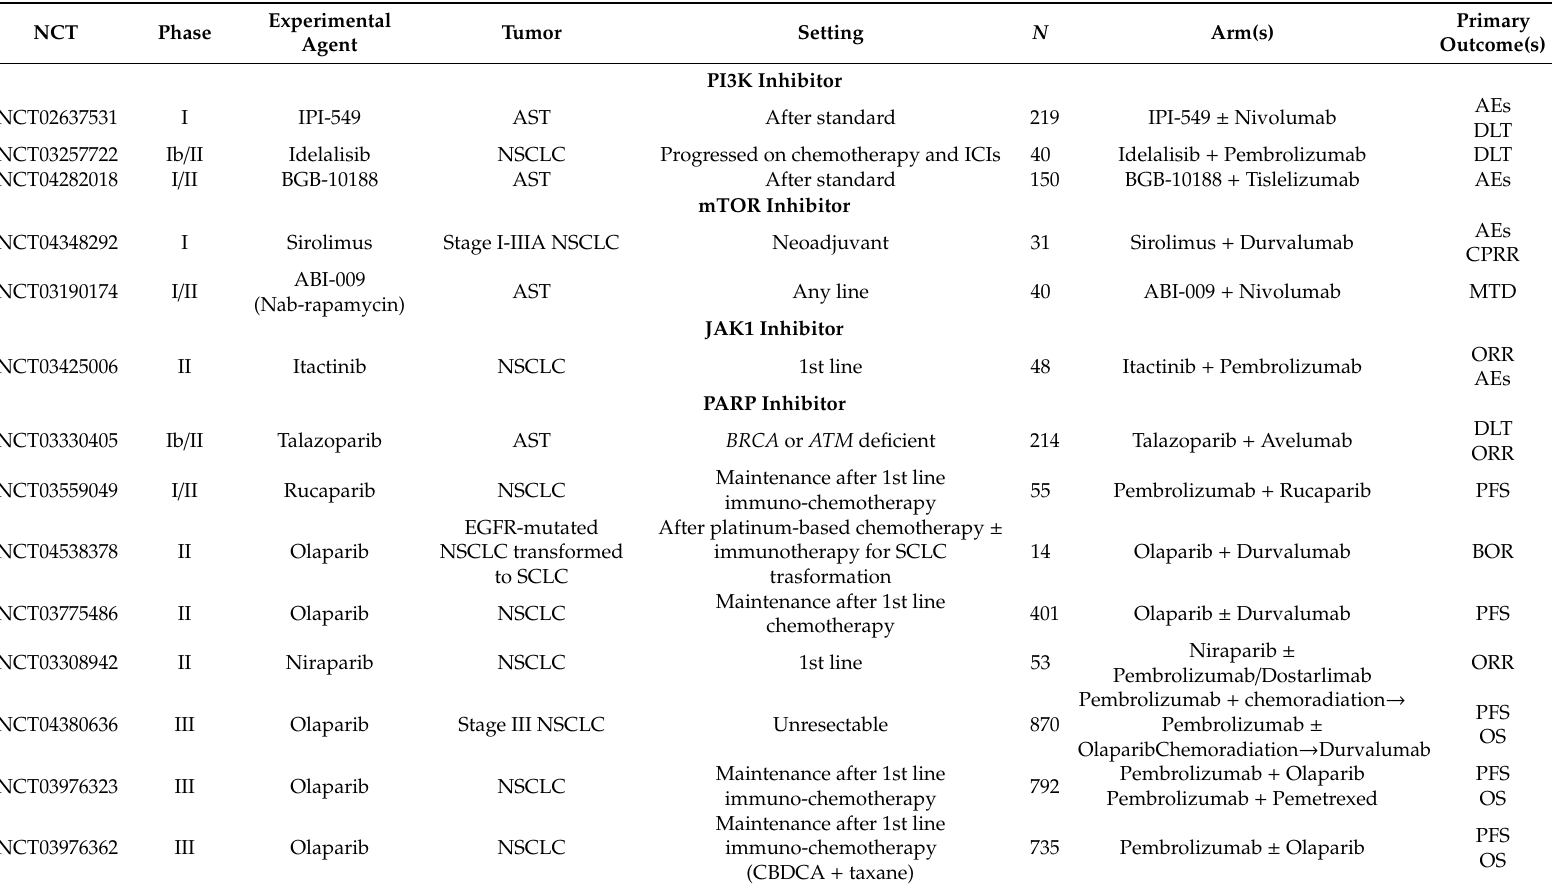
Table 1. Ongoing clinical trials of therapies targeting PD-L1 expression regulation, in combination with immune checkpoint inhibitors (ICIs) in non-small-cell lung cancer (NSCLC): (source: www.clinicaltrials.gov, last accessed: 9 September